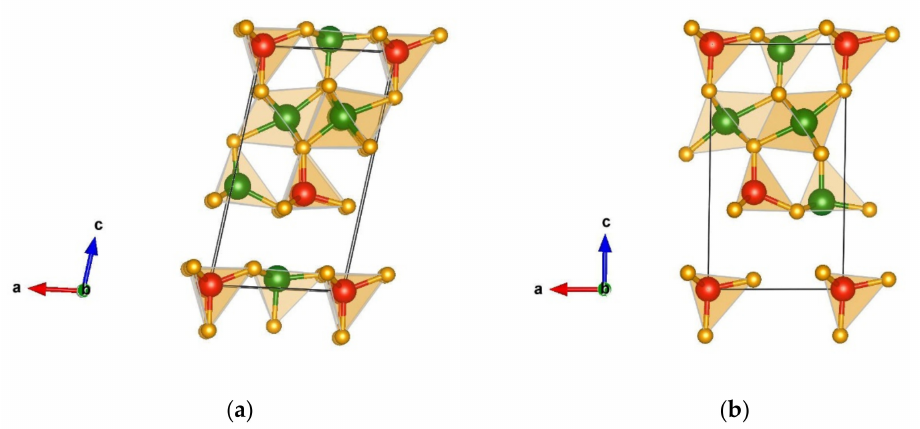
Figure 3. Visualization of favorable Cr2SiN4 modifications found in space group Pm (no. 6): ( a ) λ - Cr2SiN4-type; ( b ) λ (cid:48) - Cr2SiN4-type. Green, red, and yellow spheres denote Cr, Si, and N atoms,